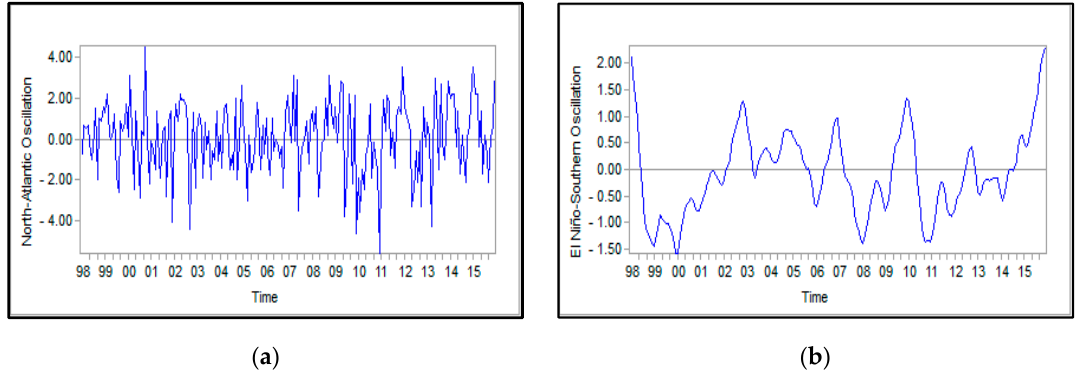
Figure A6. Monthly mean values for the NAO index ( a ) and ENSO index ( b ) obtained from database